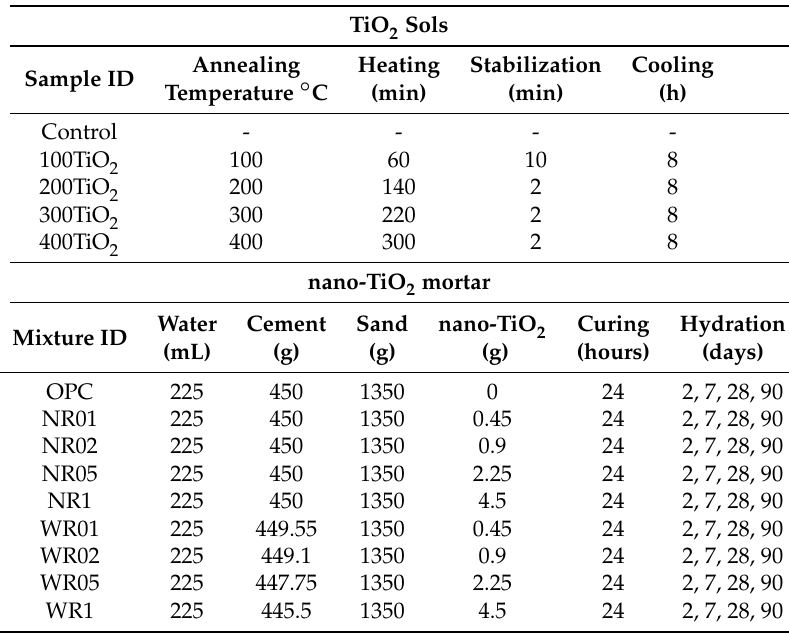
Table 2. Summary of experimental conditions for the samples